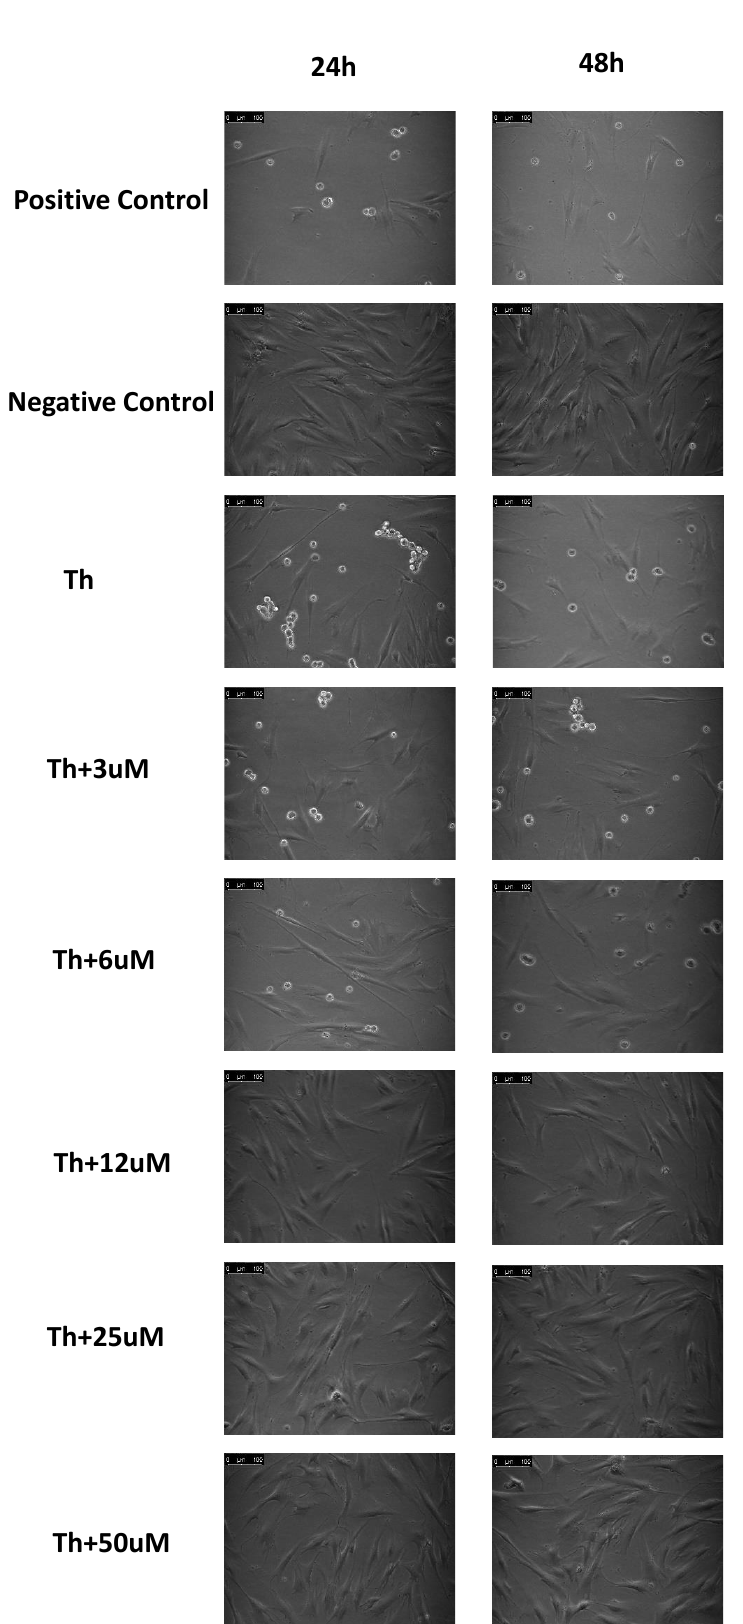
Figure 7. Effect of the PERK inhibitor LDN-0060609 on morphology of HTM cells, with induced ER stress conditions, after 24 h and 48 h incubation.